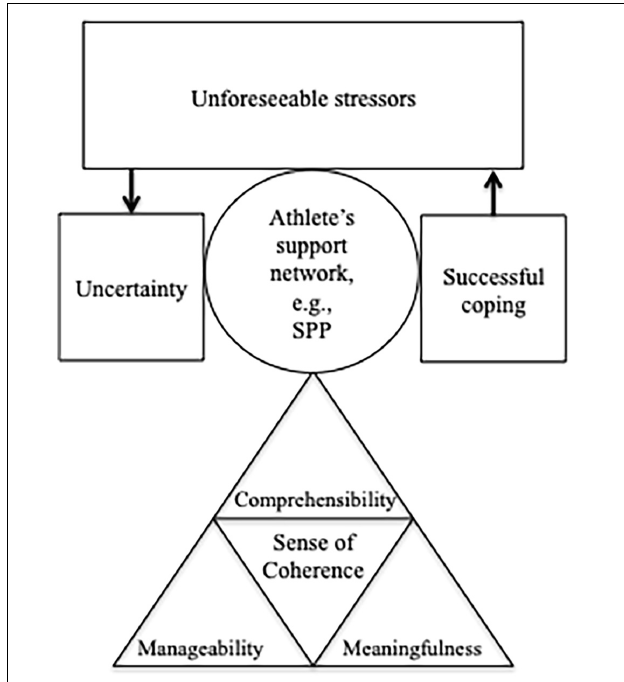
FIGURE 1 | The salutogenesis model: the sense of coherence helps the individual to balance the stress caused by uncertainty via successful coping strategies (own